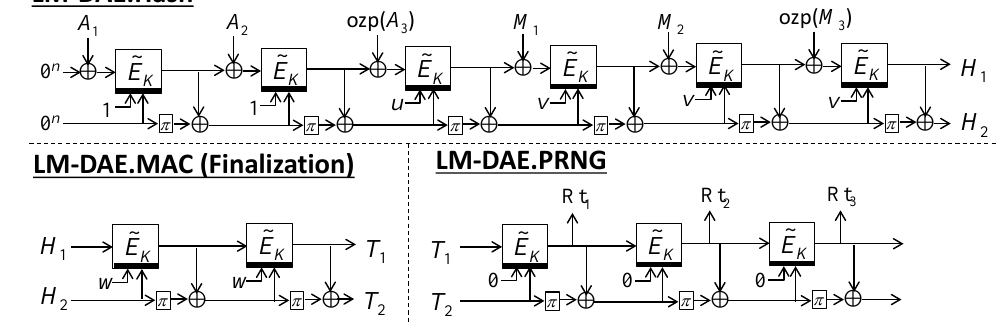
Figure 9: LM-DAE where a = 3 and m =